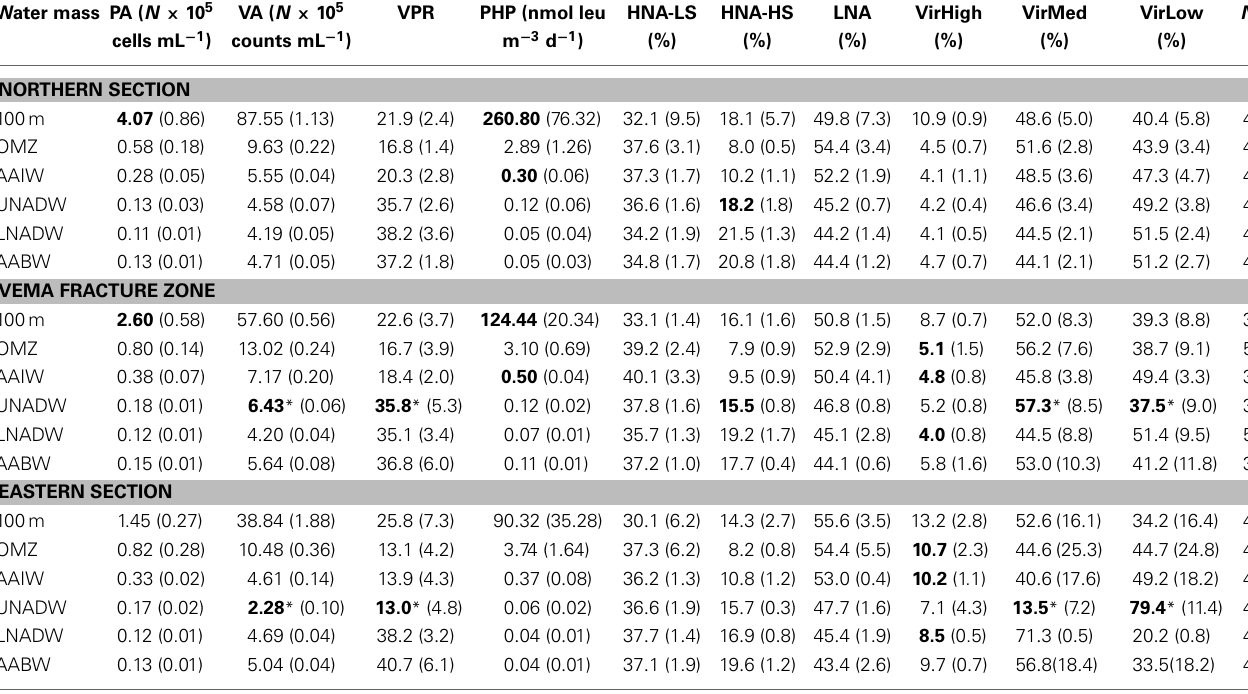
Table 1 | Prokaryotic and viral parameters determined by flow cytometry during the MOCA cruise sampled in six different water masses north (Northern section), within and east (Eastern section) of the Vema Fracture Zone in the (sub)tropical North Atlantic